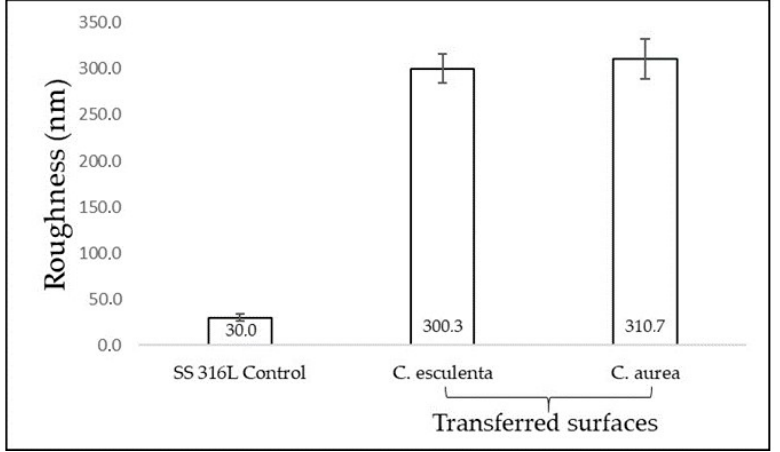
Figure 5. Average roughness of control (SS316L) and transferred (experimental) surfaces.